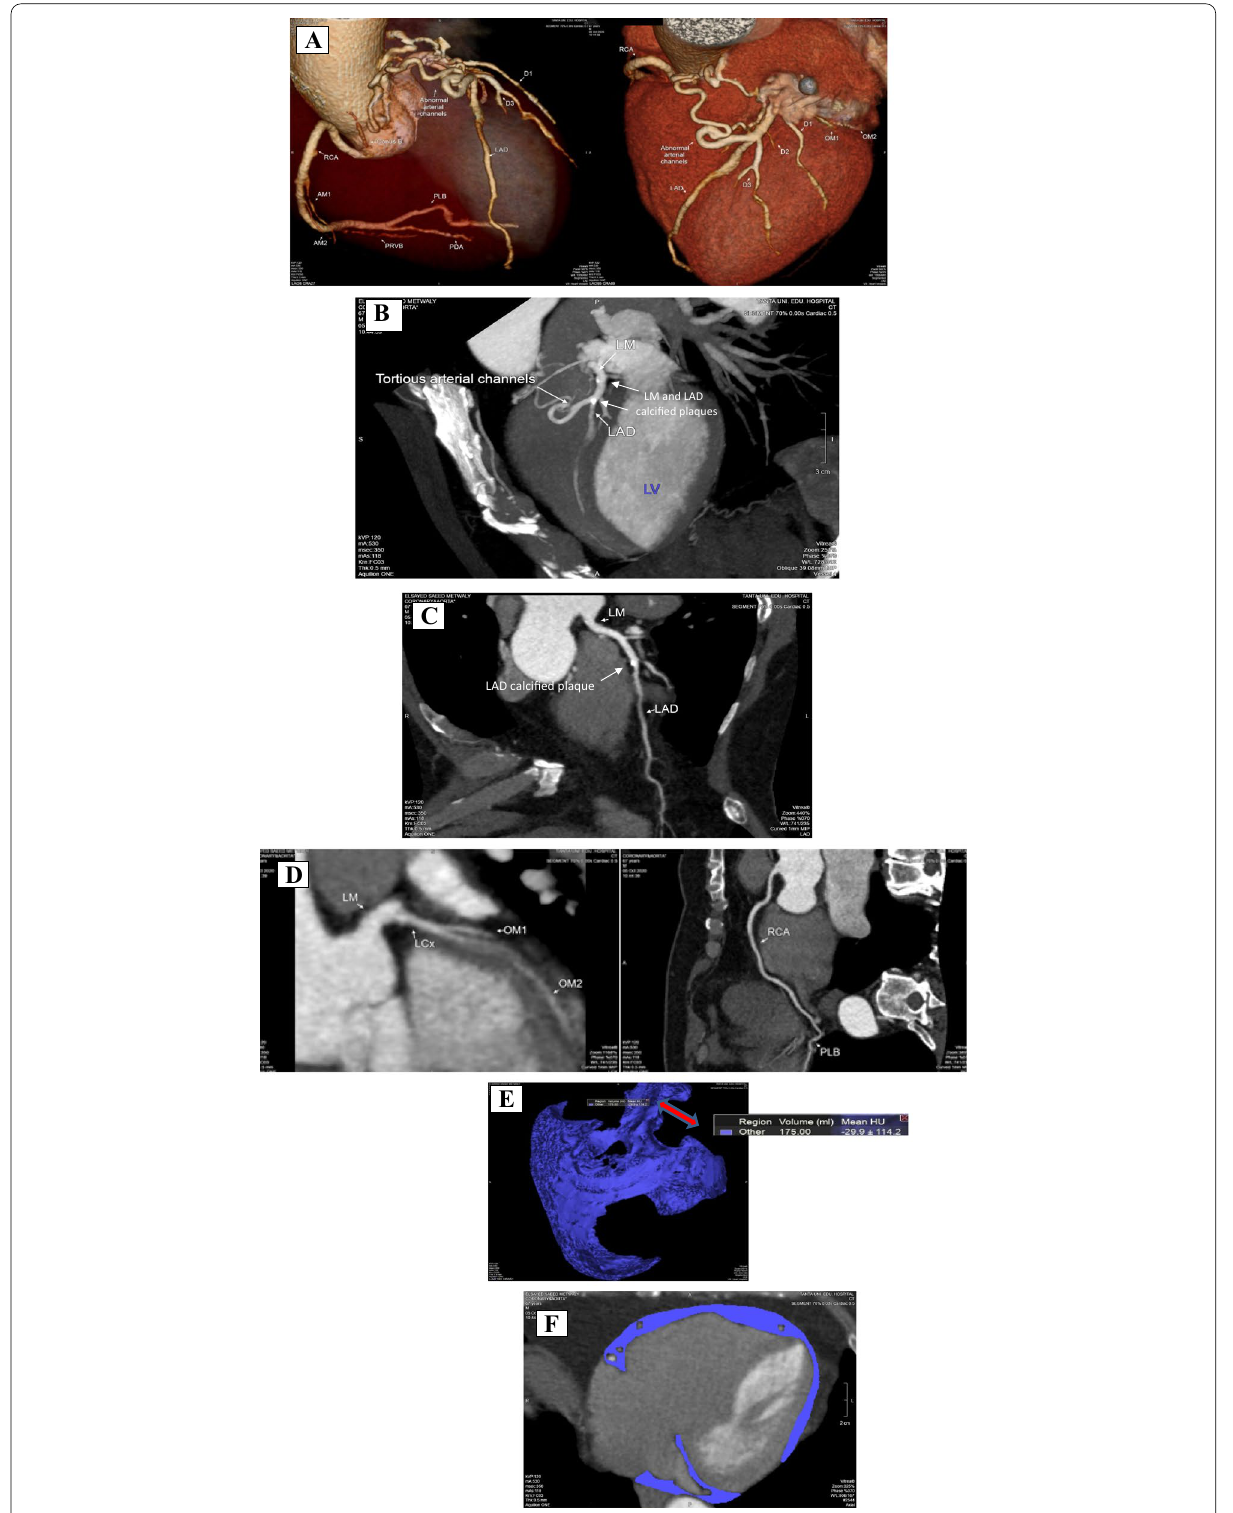
Fig. 3 (See legend on previous